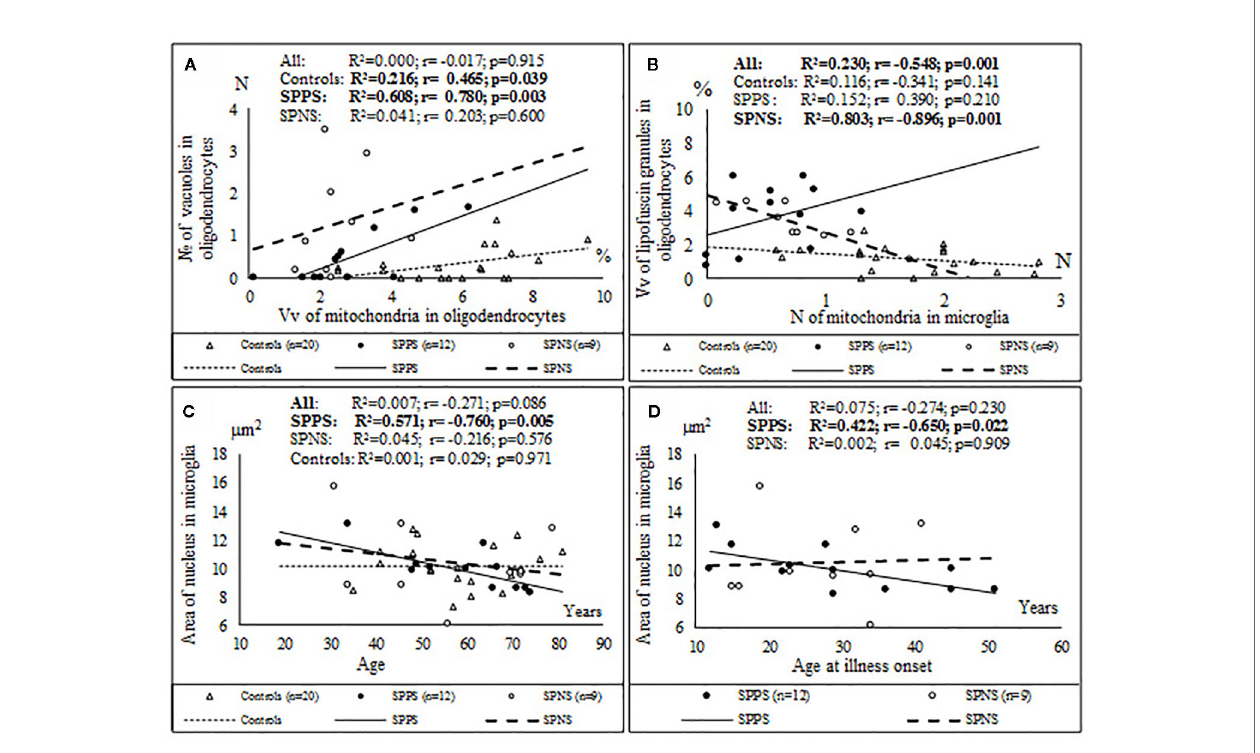
FIGURE 5 | Positive signi fi cant correlations between Vv of mitochondria in oligodendrocytes and N of vacuoles in oligodendrocytes in the SPPS subgroup and in the control group (A) ; negative signi fi cant correlations between N of mitochondria in microglia and Vv of lipofuscin granules in oligodendrocytes in the SPNS subgroup (B) and negative signi fi cant correlations between area of nucleus of microglia and age (C) and age at onset of disease (D) in the SPPS